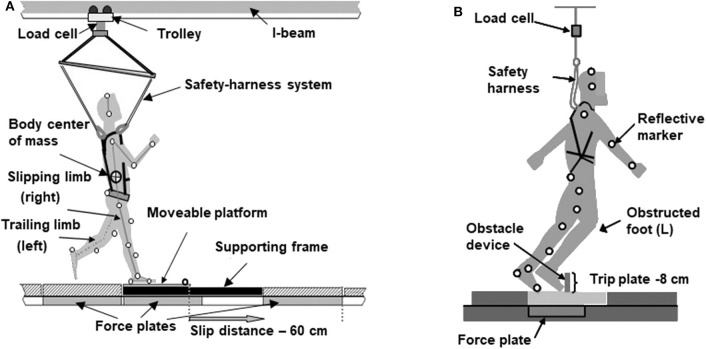
(A) Schematic diagram that indicates the experimental slip set-up demonstrating the participant in a safety harness attached to the load cell and reflective markers attached to the anatomical landmarks. As the right heel of the participant land on the moveable platform, it is unlocked to slide up to a distance of 60 cm. (B) The experimental trip set-up demonstrating the trip plate in its upright position as an obstacle to induce a trip.